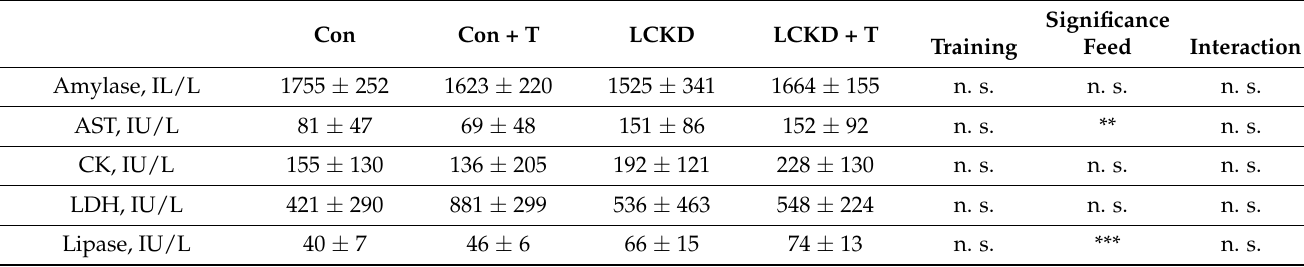
Table 5. The effect of LCKD feeding and/or training on plasma muscle/organ damage indicators. Con Con + T LCKD LCKD + T